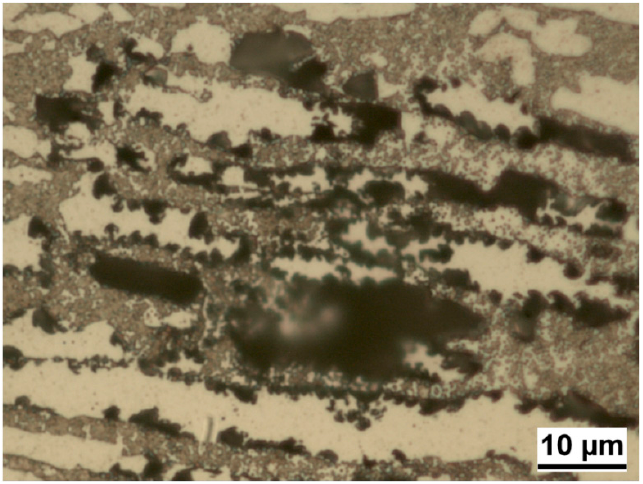
Figure 6. Micrograph of DSS 2304 electrode aged for 10 min at 750 °C after CPT test in 0.1 M NaCl solution (etching with Beraha’s reagent).